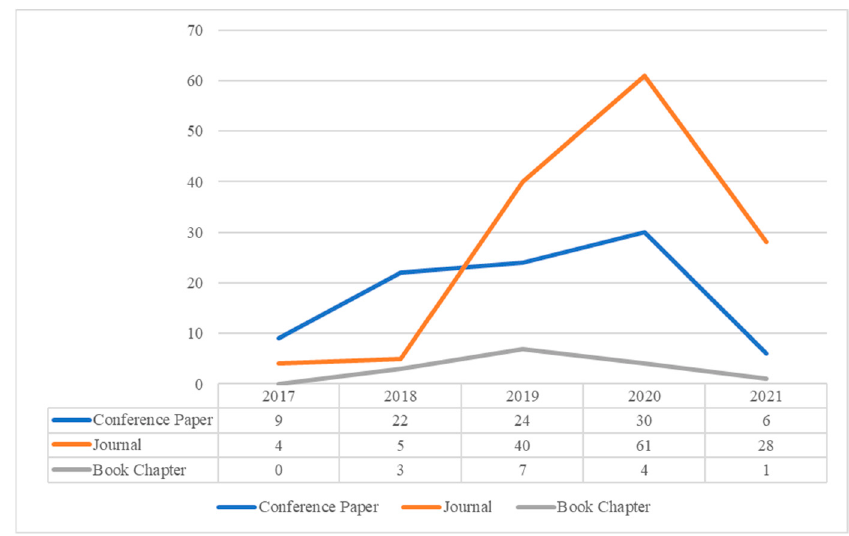
Figure 5. Distribution of studies from 2017 to